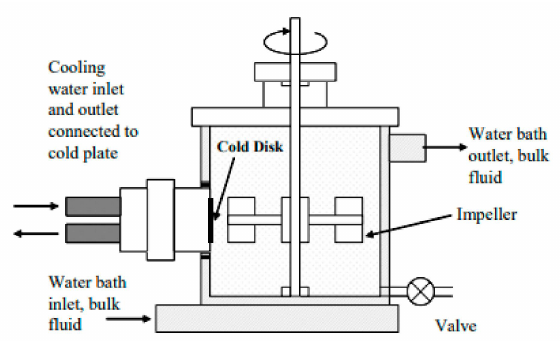
Figure 6. The schematic diagram of the stirred cell to measure wax deposition [107].